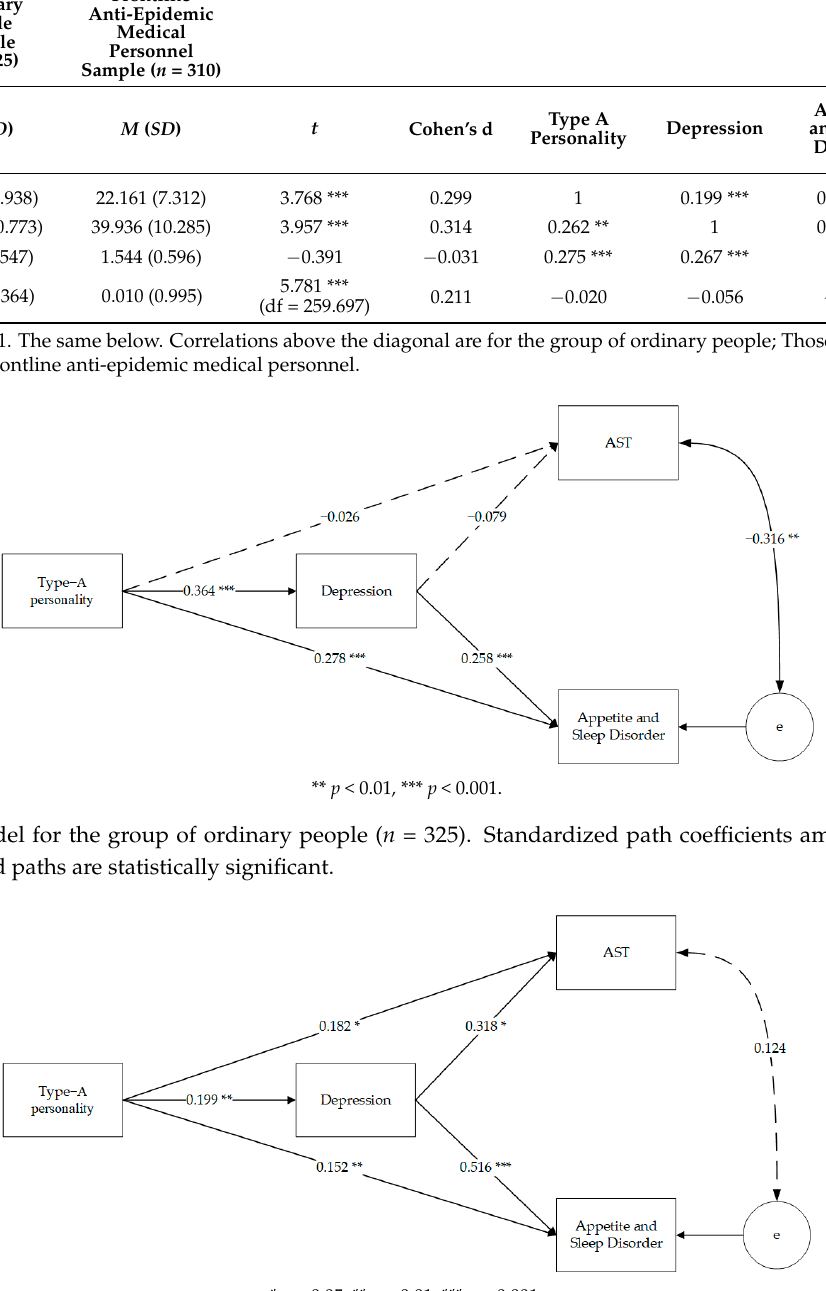
Table 1. Correlation coefficients and independent samples t -test.